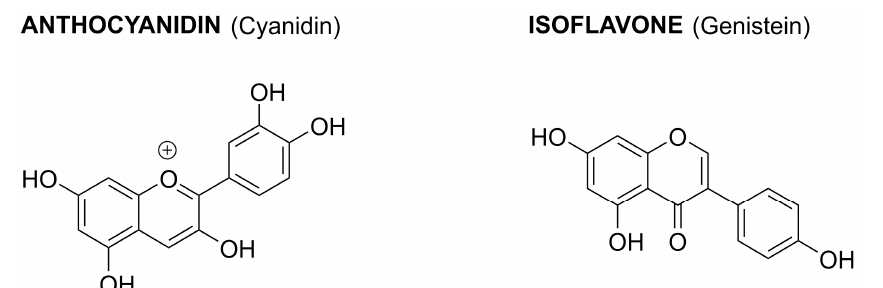
Figure 1. Structures of Representative Flavonoids from the Six Classes.